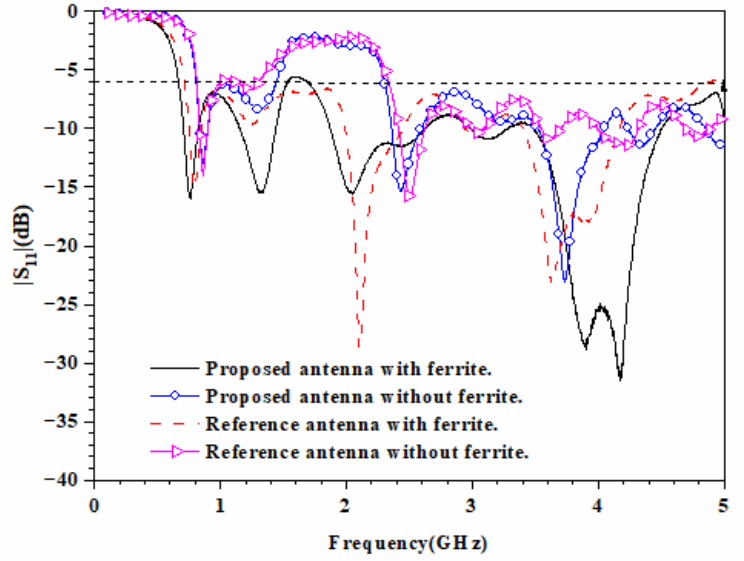
Figure 9. Measured |S 11 | of the proposed antenna and the reference antenna. The effects of the ferrite’s position on |S 11 | of the proposed antenna are also investi- gated. Figure 10 shows the measured |S 11 | of the proposed antenna with ferrite slab on the ground plane versus the parameters of ferrite’s position d and t . Figure 11 shows the measured |S 11 | of the proposed antenna with a ferrite slab on the top layer. Table 1 gives the bandwidth of the proposed antenna shown in Figures 10 and 11. As shown in the table, the loading of the ferrite slab at any position results in the frequency band shifting to the lower compared with the case of no ferrite slab loading. The antenna with a ferrite slab on the ground plane has a lower left cutoff frequency than the one with a ferrite slab on the top layer with the same values of parameters d and t . The proposed antenna has the widest bandwidth when the ferrite slab is loaded on the ground plane covering the circular slot with d = 0 mm and t = 2.5 mm.